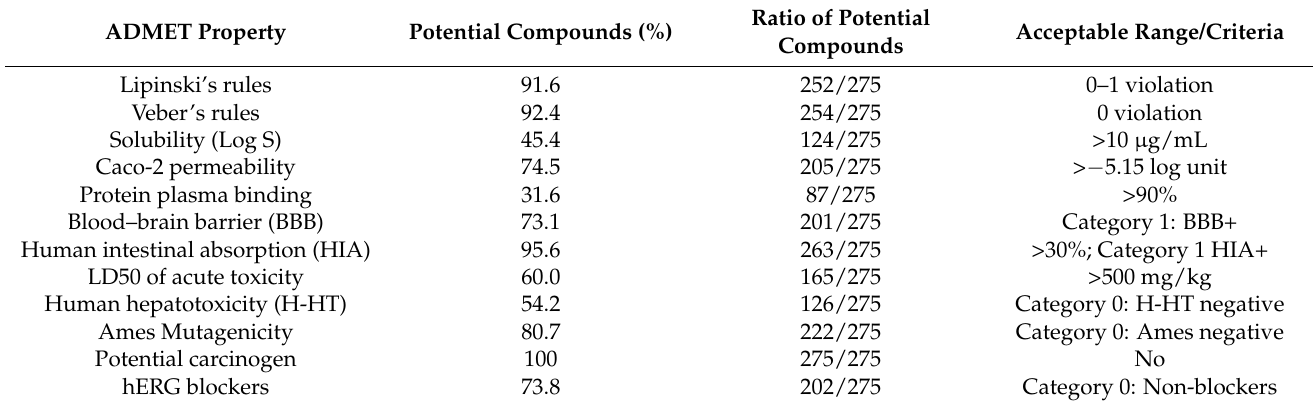
Table 3. Summary of ADMET parameters for potential